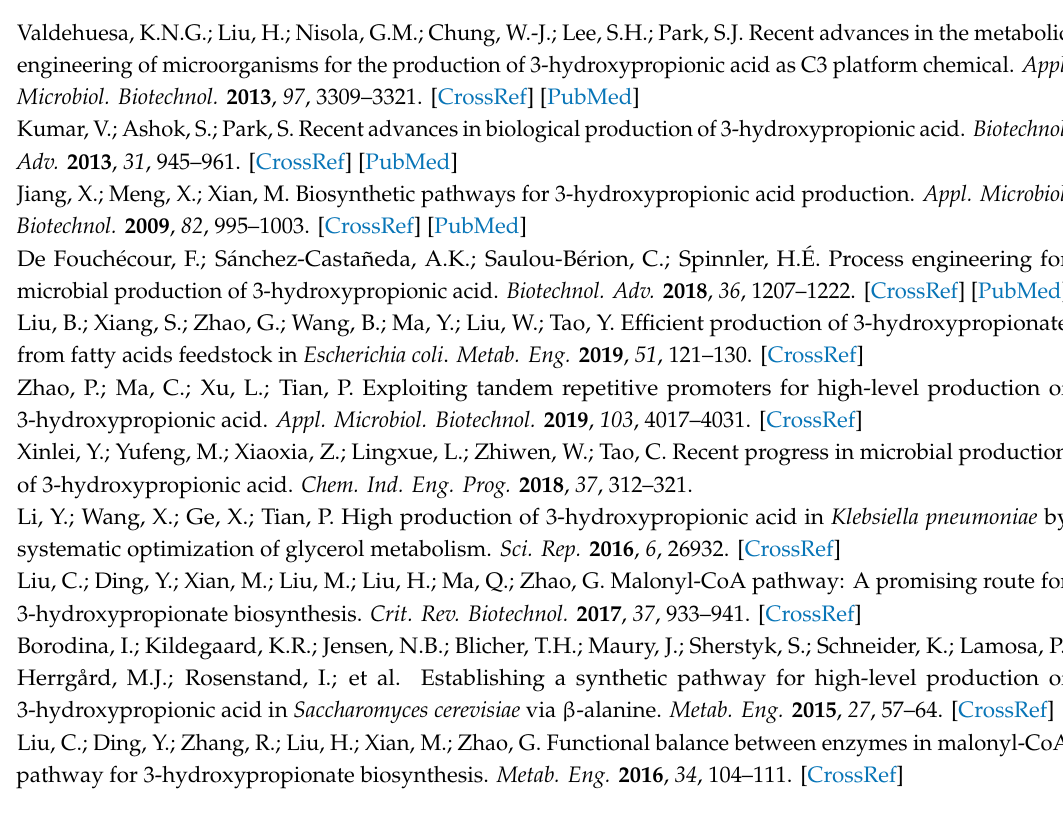
Figure S1: Time profiles of acetate consumption (open symbols) and biomass (red filled symbols) of strains Cgz4 (squares), Cgz5 (circles), Cgz6 (upward triangles) and Cgz7 (downward triangles) with 10 g / L acetate, Figure S2: Time profiles of the biomass (OD 600 ), glucose, acetate, and 3-HP concentrations of strain Cgz5 grown (a) with 5 g / L glucose and 5 g / L acetate, (b) with 10 g / L glucose and 10 g / L acetate, Figure S3: Time profiles for biomass (OD 600 ), glucose, and organic acids in the fermentation broth of strain Cgz5 grown in medium with an initial 15 g / L glucose and 5 g / L acetate with 30 µ M cerulenin being added at 6 h, Figure S4: Time profiles for biomass (OD 600 ), glucose, and organic acids in the fermentation broth of strain Cgz5 grown in medium with an initial 15 g / L glucose and 5 g / L acetate with 60 µ M cerulenin being added at 6 h, Figure S5: Time profiles for biomass (OD 600 ), glucose, and organic acids in the fermentation broth of strain Cgz5 grown in medium with an initial 15 g / L glucose and 5 g / L acetate with 100 µ M cerulenin being added at 6